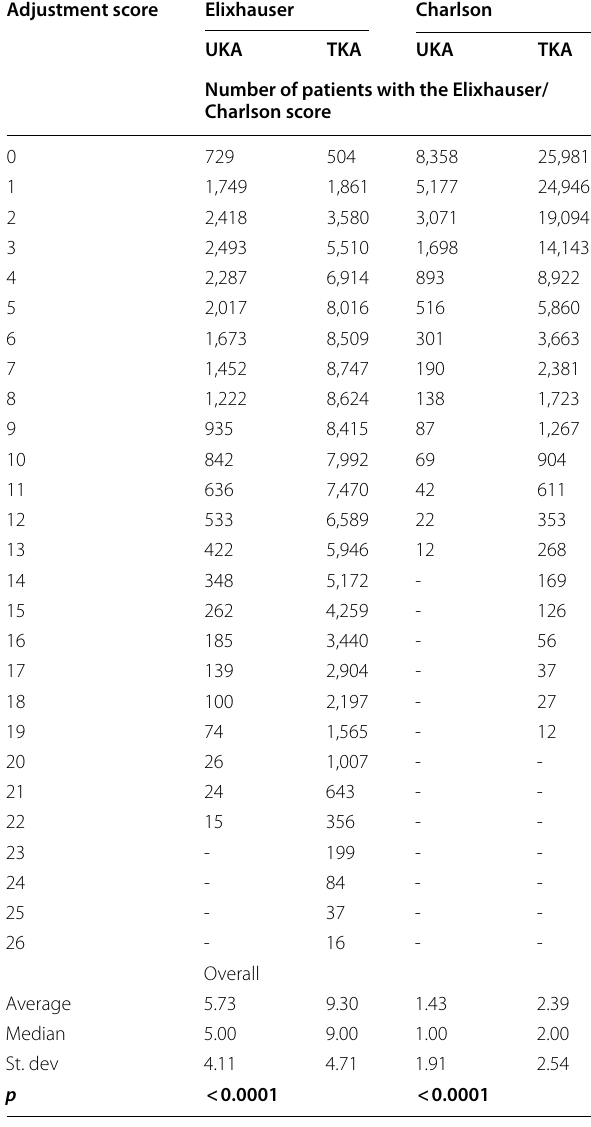
Table 9 Elixhauser and Charlson comorbidity adjustment scores for UKA and TKA Adjustment